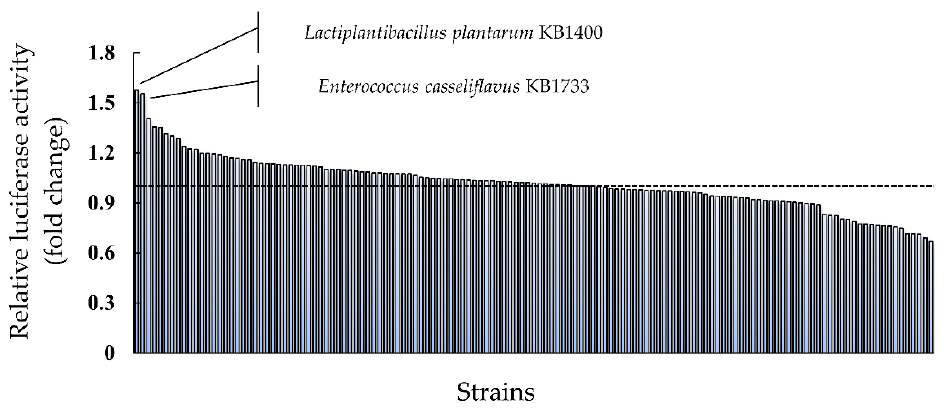
Figure 1. Screening for the potent LAB strain with an ability to induce the expression of the IFN- λ 3 gene among 135 strains. Dotted line indicates the value of relative luciferase activity of the control as 1.0. The value for each of the 135 strains is listed in Supplementary Table S2. Data from a single experiment are shown.